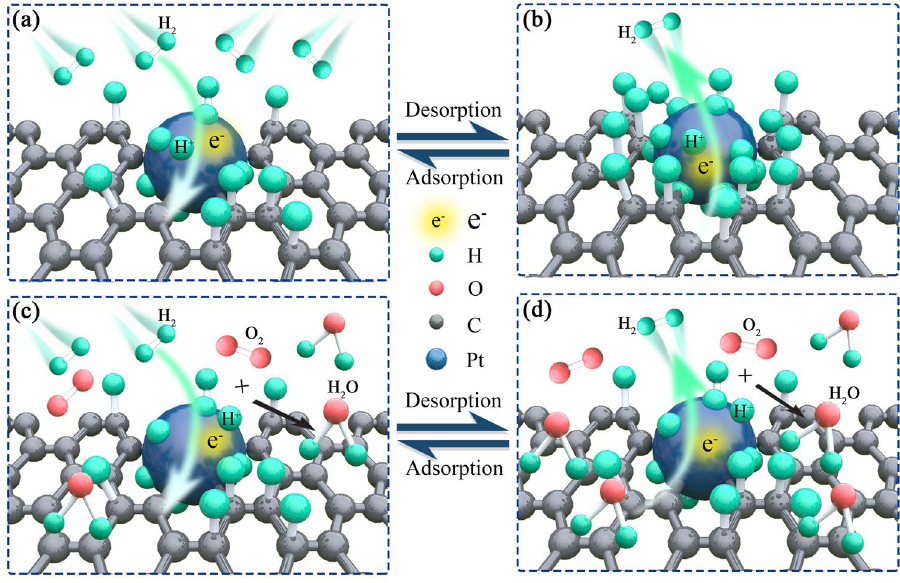
Figure 5. Sensing mechanism. ( a ) Adsorption and ( b ) desorption processes of H 2 mixed in argon. ( c ) Adsorption and ( d ) desorption processes of H 2 mixed in